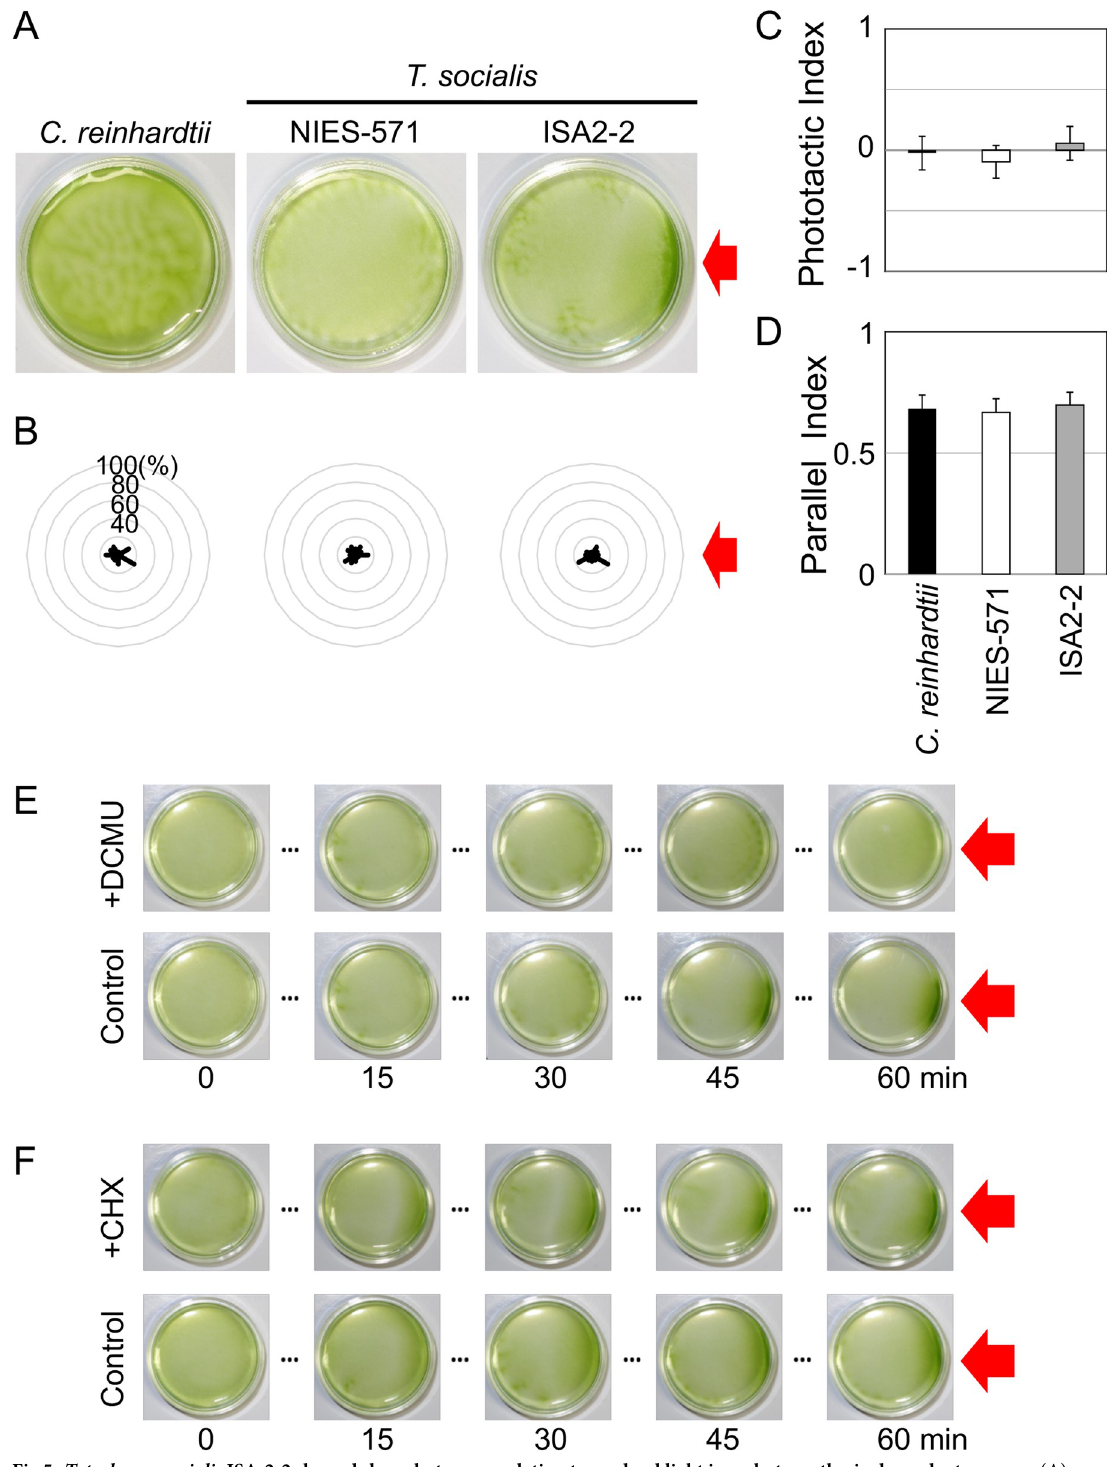
Fig 5. Tetrabaena socialis ISA-2-2 showed slow photoaccumulation toward red light in a photosynthesis-dependent manner. (A) Suspensions of wild-type C . reinhardtii and T . socialis NIES-571 and ISA2-2 strains were illuminated with red light ( λ = 640 nm, 30 μ mol photons m − 2 s − 1 ) from the right side for 15 min. (B) Polar histograms representing the percentage of cells/colonies moving in a particular direction relative to the red light illumination (12 bins of 30˚; n = 30 cells/colonies per strain) for 3 s following 30-s illumination. (C) Phototactic indices (average of cos θ ) and (D) parallel indices (average of |cos θ |) calculated from (B). Values were not significantly different